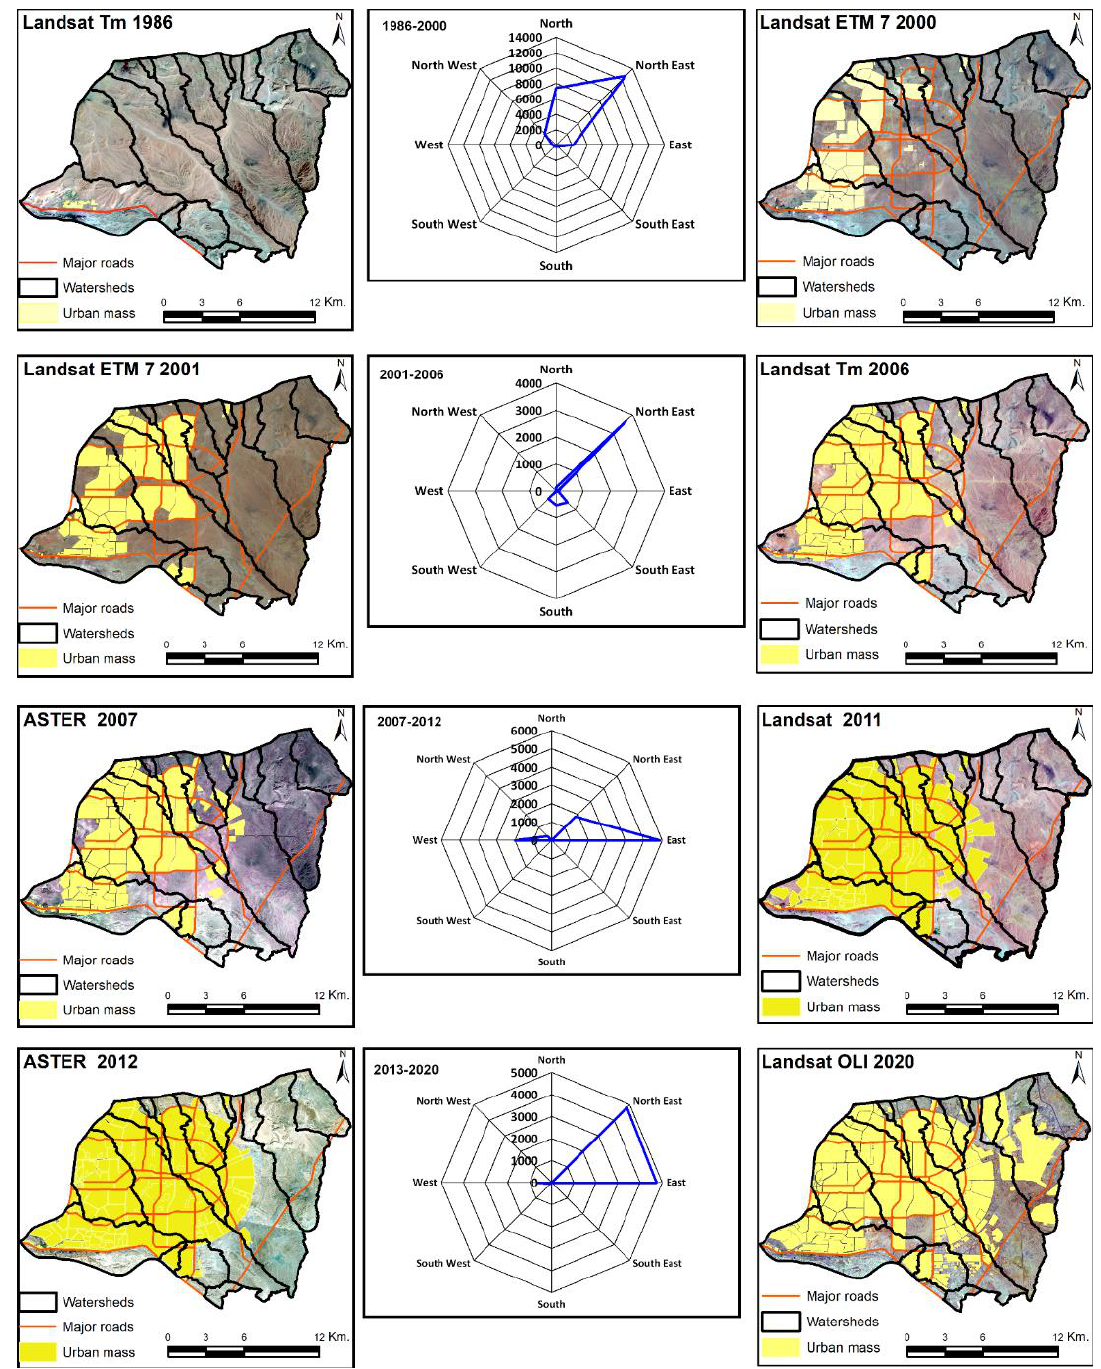
Figure 8. The directions of spatial urban expansions through the main time periods extending from 1986 to 2020.